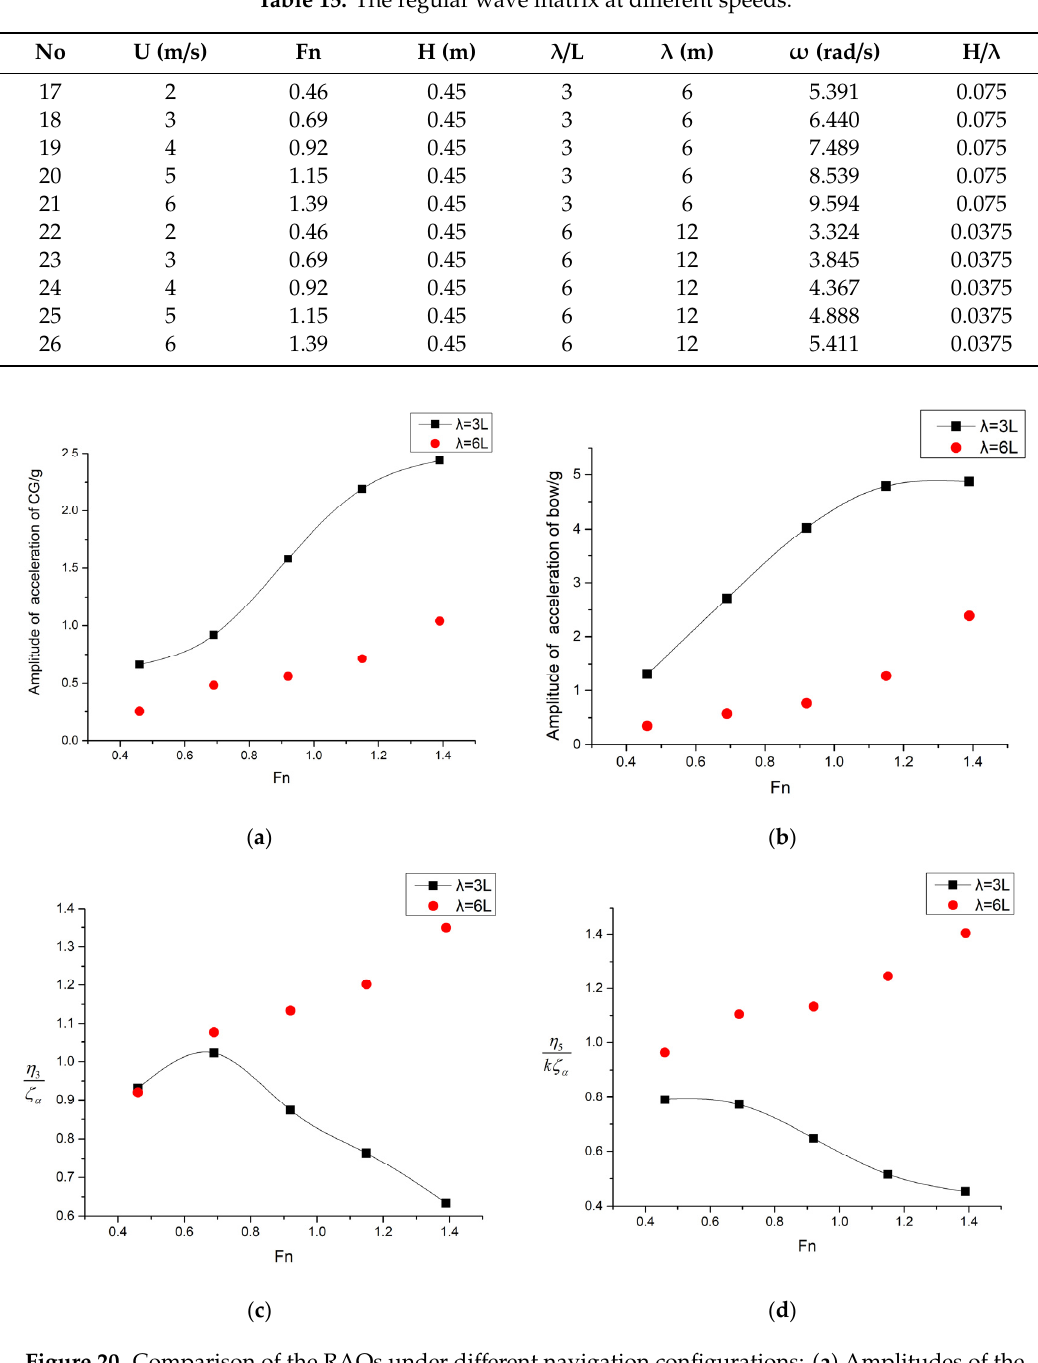
Figure 20. Comparison of the RAOs under different navigation configurations: ( a ) Amplitudes of the acceleration of the CG; ( b ) Amplitudes of the acceleration of the bow; ( c ) Amplitudes of the heave; ( d ) Amplitudes of the pitch.